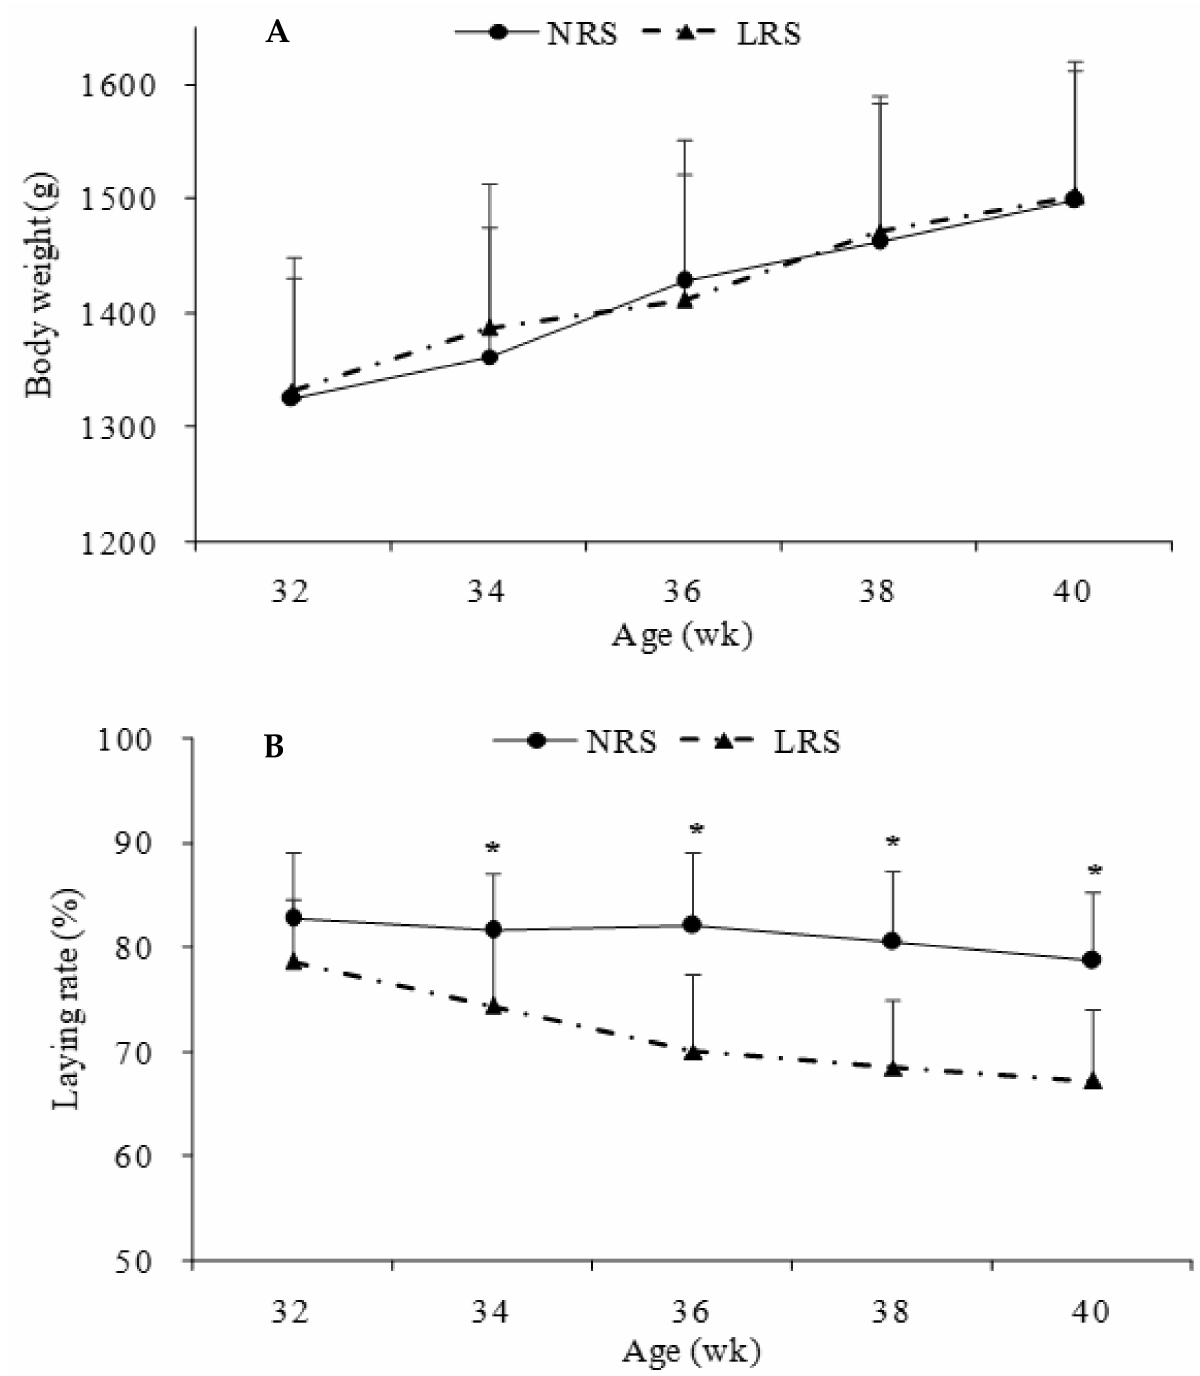
Figure 4. Body weights ( A ) and laying rates ( B ) of hens in the two housing system houses from 32 to 40 weeks of age. Dotted lines represent the floor-litter housing system (LRS), and solid lines represent the plastic-net housing system (NRS). * Means with asterisk superscripts within each period are significantly different ( p <